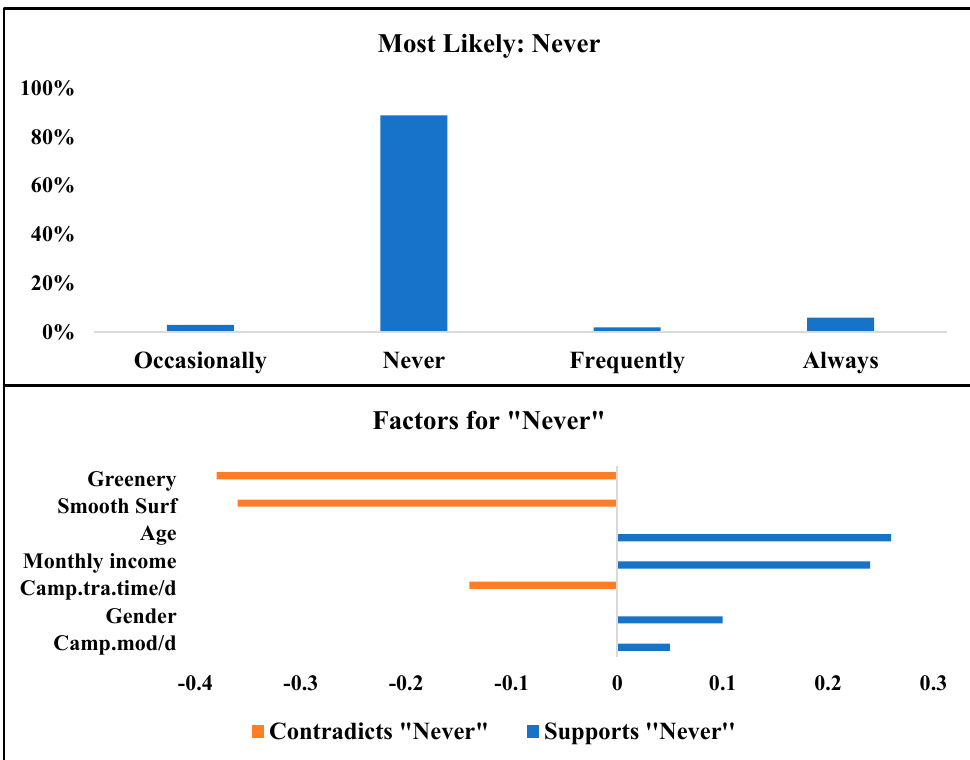
Figure 18. Optimization results and importance of variables based on the second scenario: Never use SFFESs.